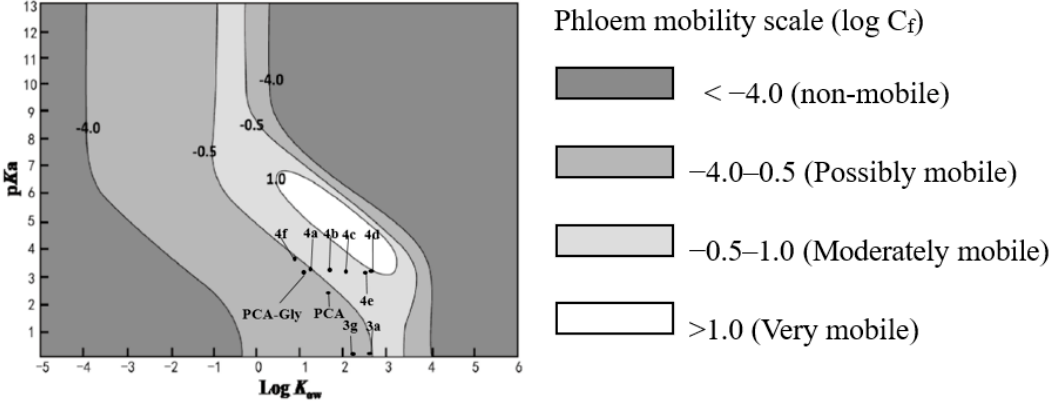
Figure 6. Prediction of phloem mobility of compounds 3a , 3g , 4a–4f , PCA-Gly , and PCA using the Kleier map (log C f as a function of p K a and log K ow ).